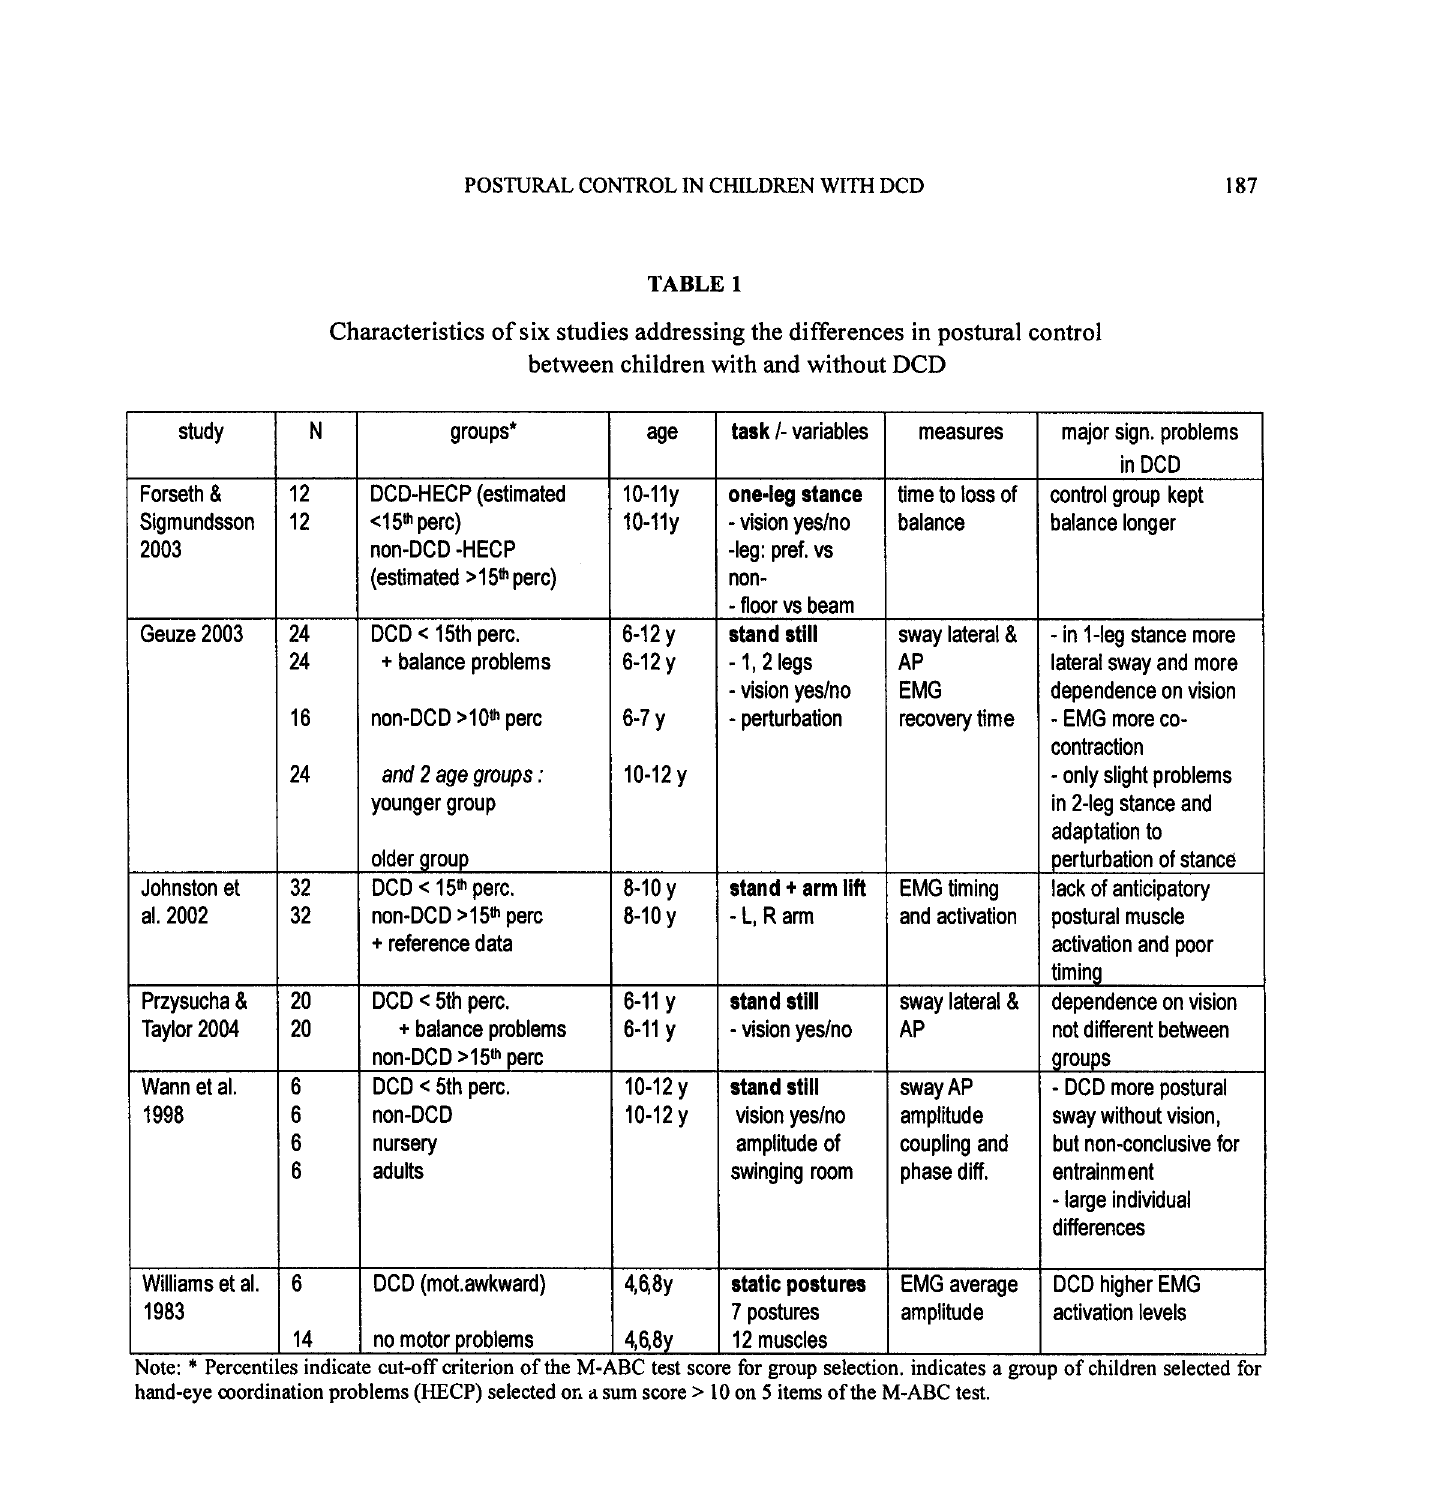
Characteristics of six studies addressing the differences in postural control between children with and without